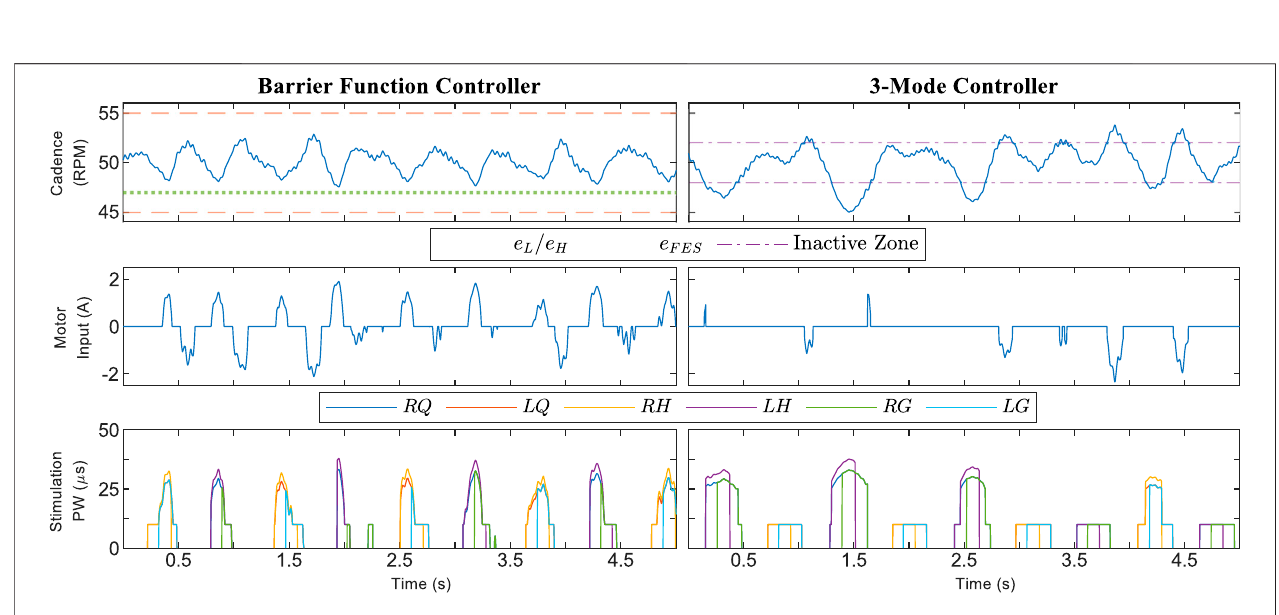
FIGURE4| CadencefromatrialusingProtocolC,whereParticipant#1wasaskedtoprovidenovolitionaleffort.The3Mcontrollerwasproblematicinthisscenario due to switching between FES and motor control. The shaded red regions in the 3-Mode plot correspond to times when the electric motor was switched off.